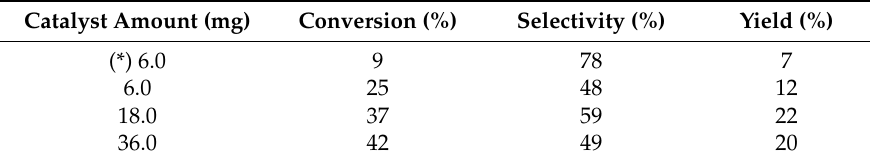
Table 3. E ff ect of the TiO 2 -SO 3 H catalyst amount on fructose dehydration in water. Catalyst Amount